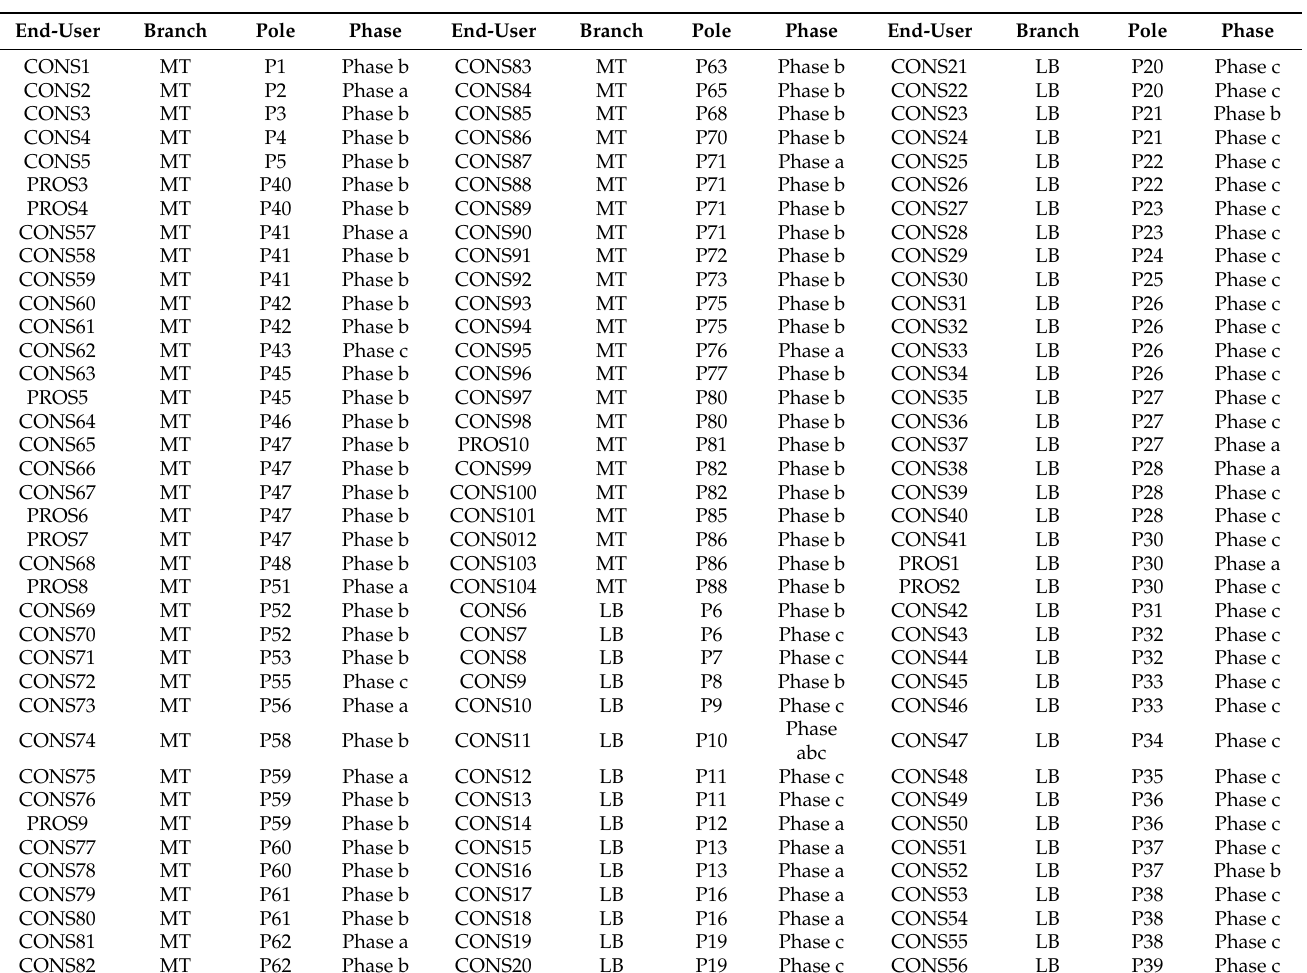
Table 5. Location and connected phase (initial situation) of the end-users in the